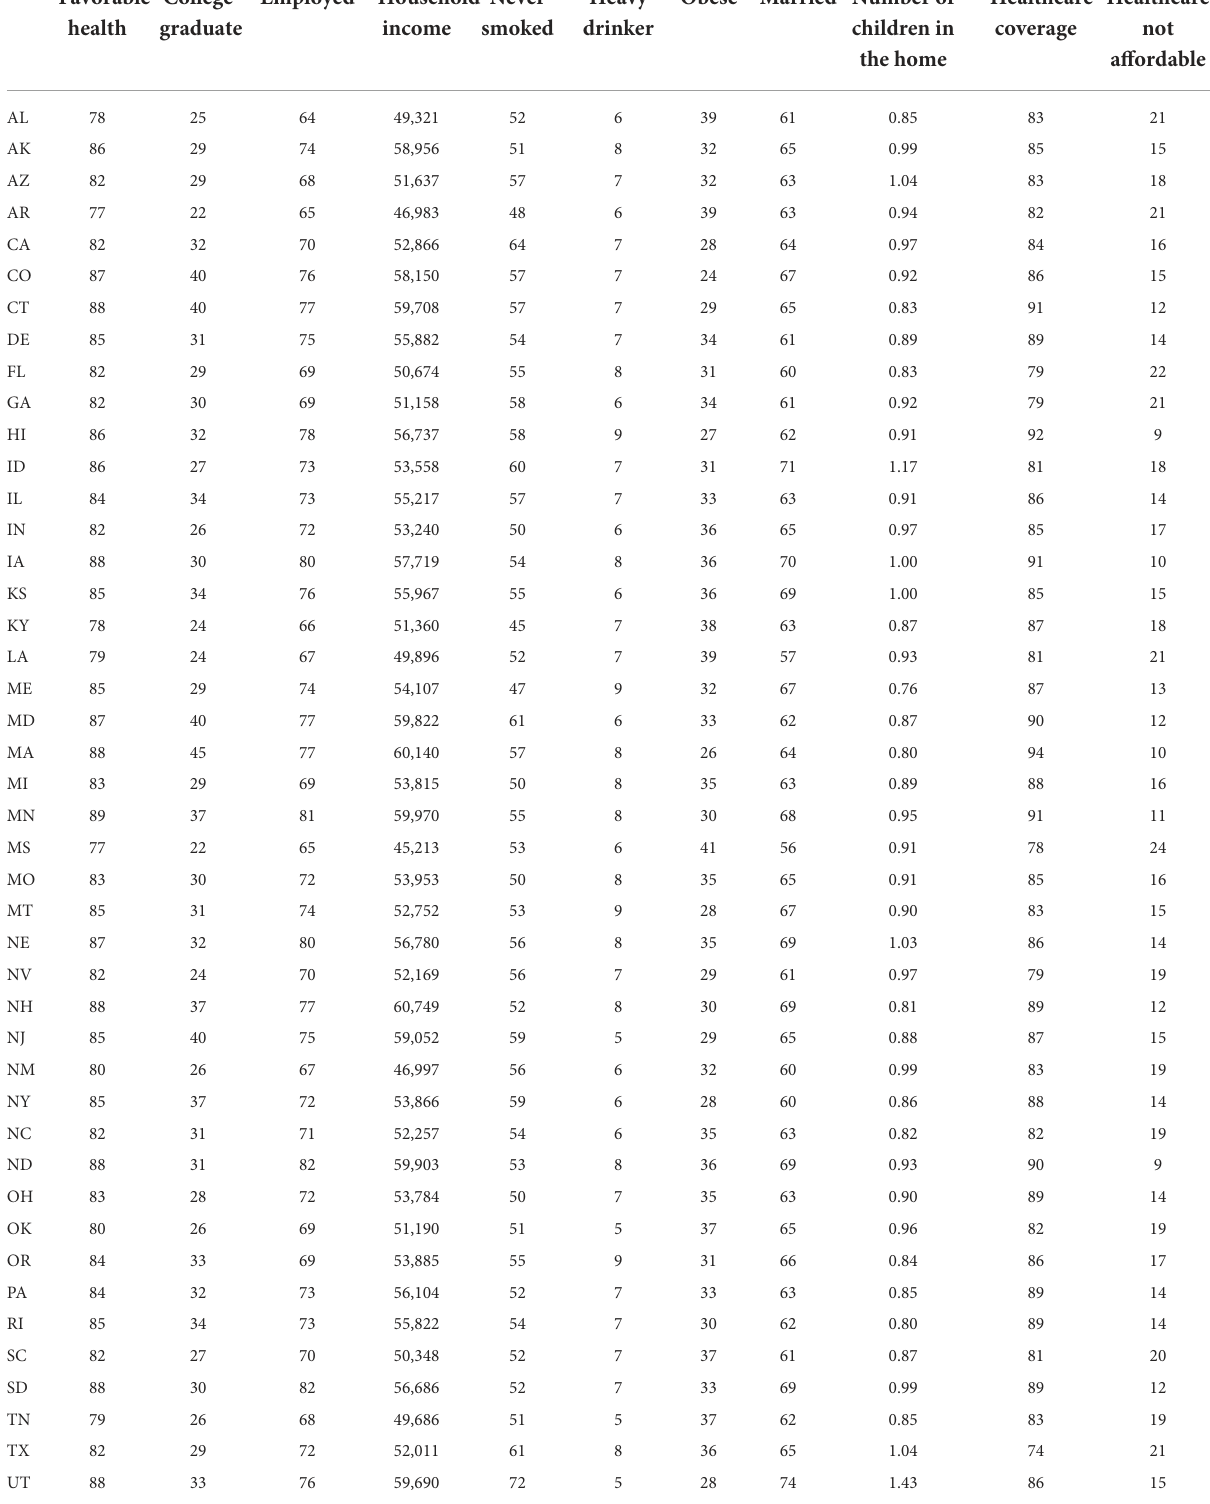
TABLE 1 Weighted descriptive statistics of U.S. adults ages 25–64 by